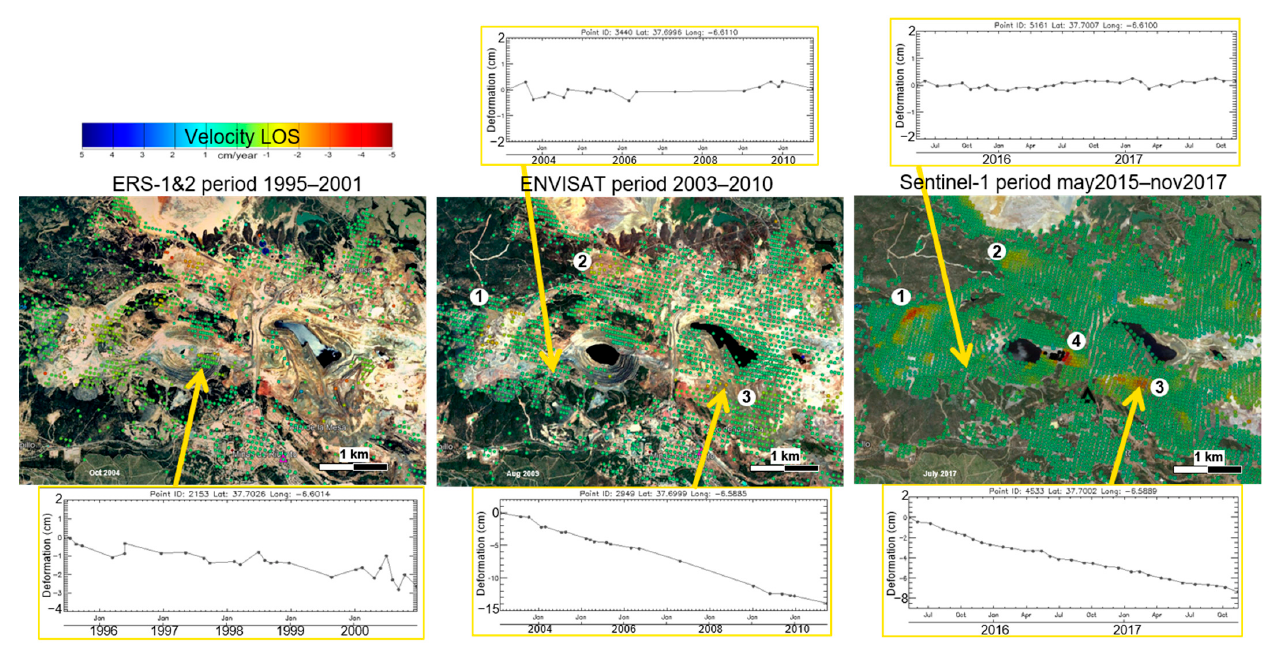
Figure 4. Historical review of Riotinto mine with 3 ESA satellites: ERS-1&2, ENVISAT, and Sentinel-1. Result for descending orbits. Dots represent mean velocity values (cm/y, in line of sight direction, LOS) of each cell. Green dots mean stable and reddish colors mean movement away from the satellite. The numbers on the maps show four areas under deformation discussed in the following sections. The graphics show accumulated deformation in stable and unstable points. It is worth noting the coverage improvement with Sentinel-1.